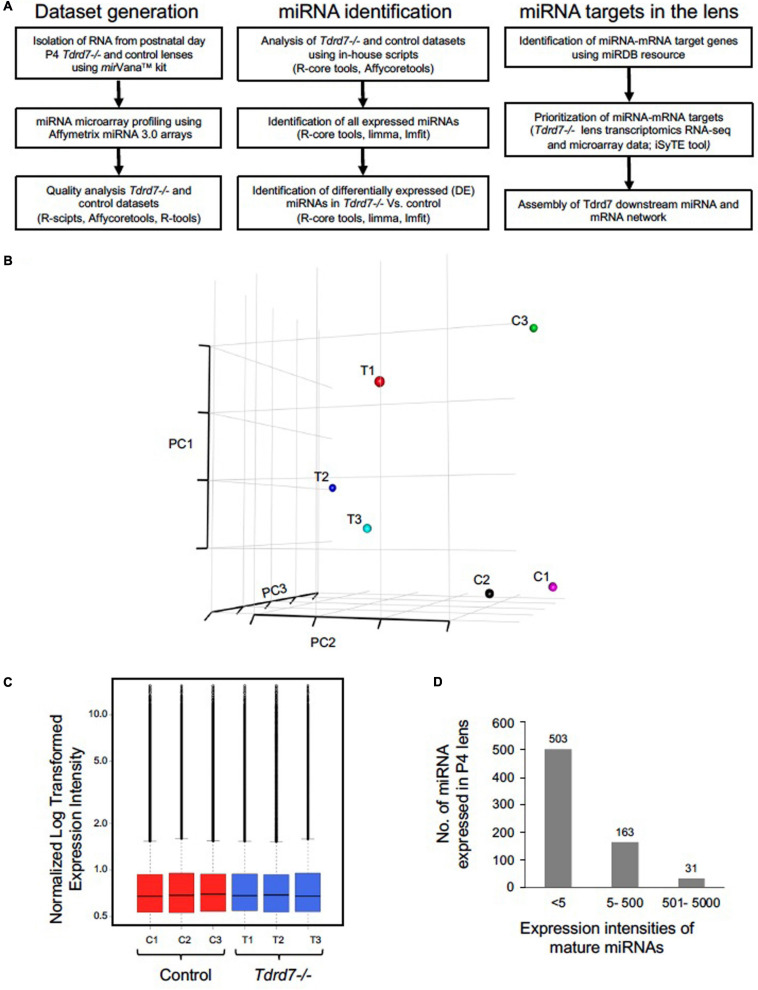
Microarray-based profiling of miRNAs in Tdrd7-/- lenses. (A) Step-by-step workflow showing bioinformatics tools and R-packages used for generation and analysis of post-natal day (P) 4 Tdrd7-/- and control lens microarray datasets, miRNA identification and miRNA-mRNA targets. (B) Comparisons of normalized expression intensities for three biological replicates for Tdrd7-/- and control using PCA analysis plots and (C) boxplot analysis. (D) Bar plot shows total number of miRNAs expressed at P4. Distribution of expression intensity for miRNAs is shown by x-axis while y-axis shows number of miRNAs expressed.